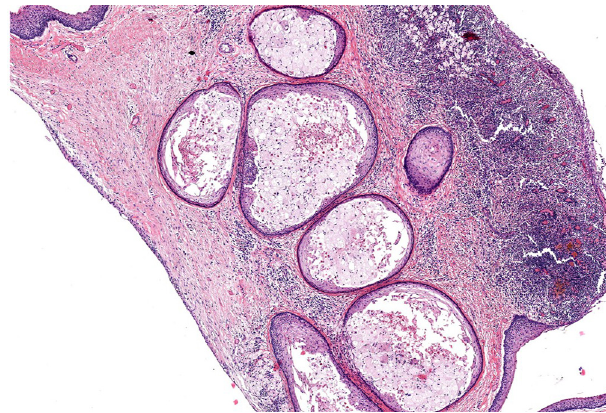
Fig. 1. Histological section of an OCK wall (10 (cid:1) magni fi cation,